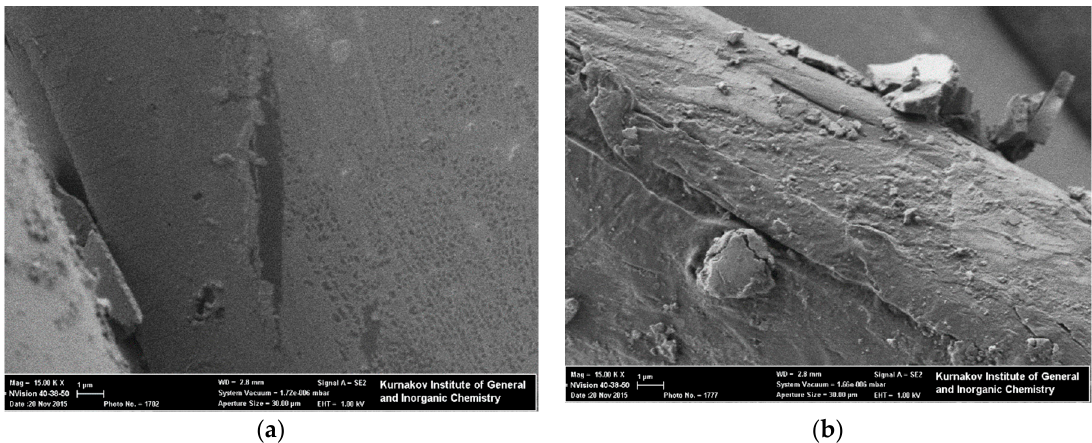
Figure 7. Polyester fabric fibres coated with TiO 2 nanoparticles (8 g / cm 2 ) before the washing ( a ); and after the washing ( b ). Scanning electron microscopy method. Table 3. Ability of a TiO 2- coatedpolyester fabric to inhibit the vital activity of pathogenic bacteria. Composition of the Modified Polyester Fabric